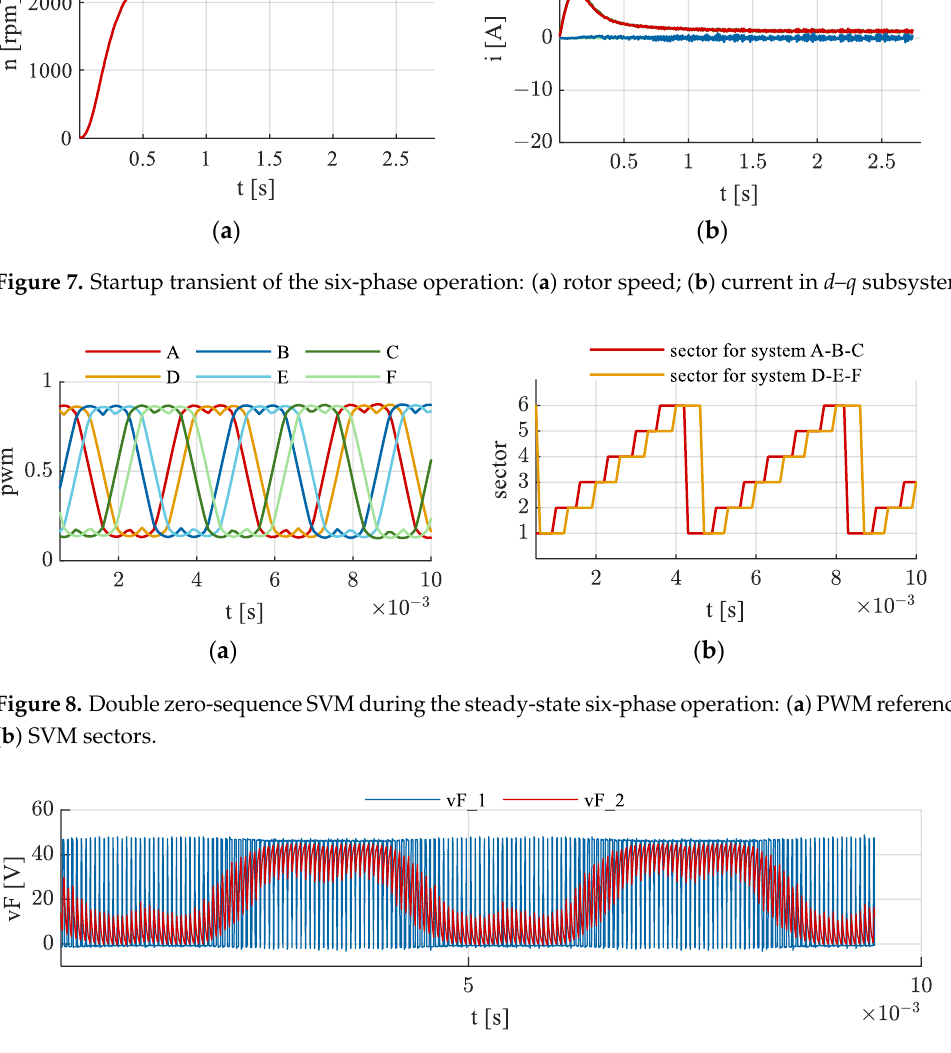
Figure 9. Oscilloscopic record of the measured voltage during the steady-state six-phase operation.